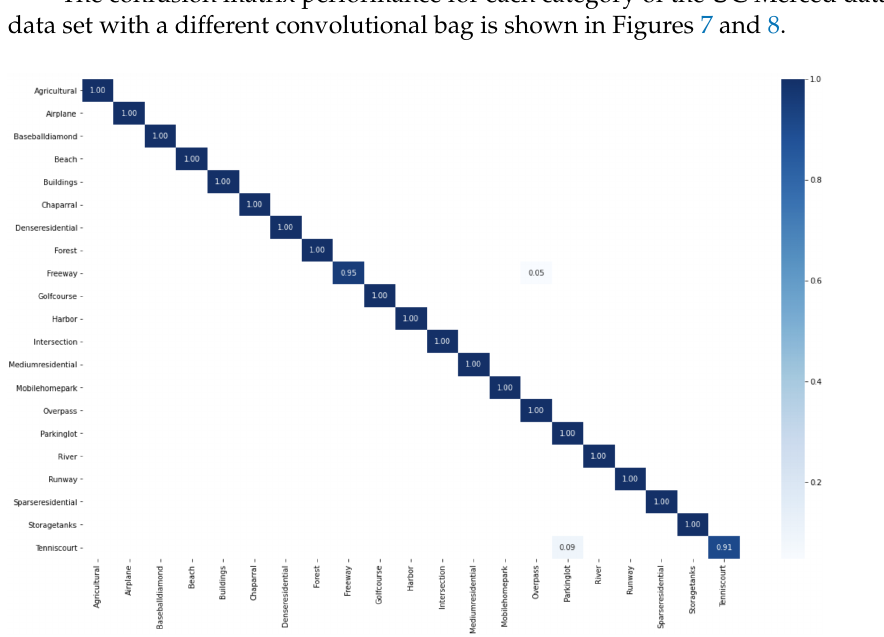
Figure 7. Confusion matrix of our method under the 80% training ratio and 50% of important features on the UC Merced data